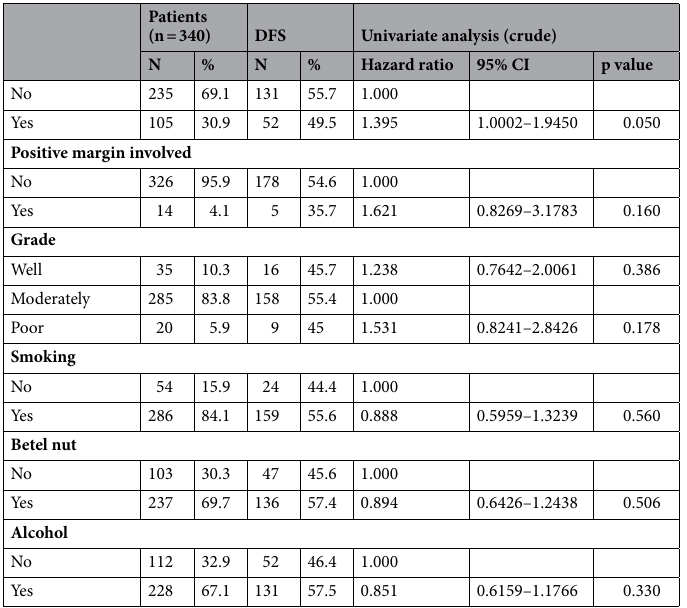
Table 1. Summary of clinicopathological features and results of univariate analysis. Follow-up period: from the date of diagnosis to December 30, 2019. W/O ND without neck dissection, RMT retromolar trigone, Early stage AJCC stage I and II, Advanced stage stage III and